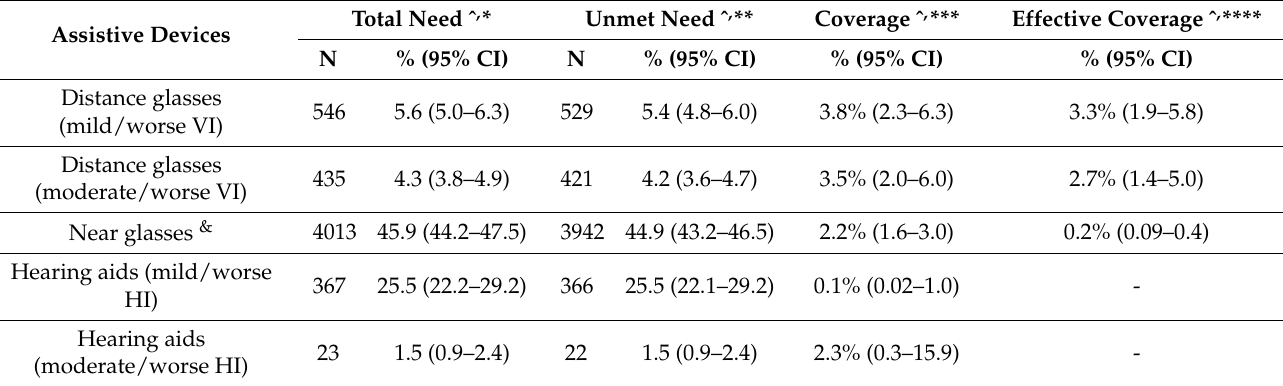
Table 2. Three assistive devices total need, unmet need, coverage and effective coverage estimates in The Gambia